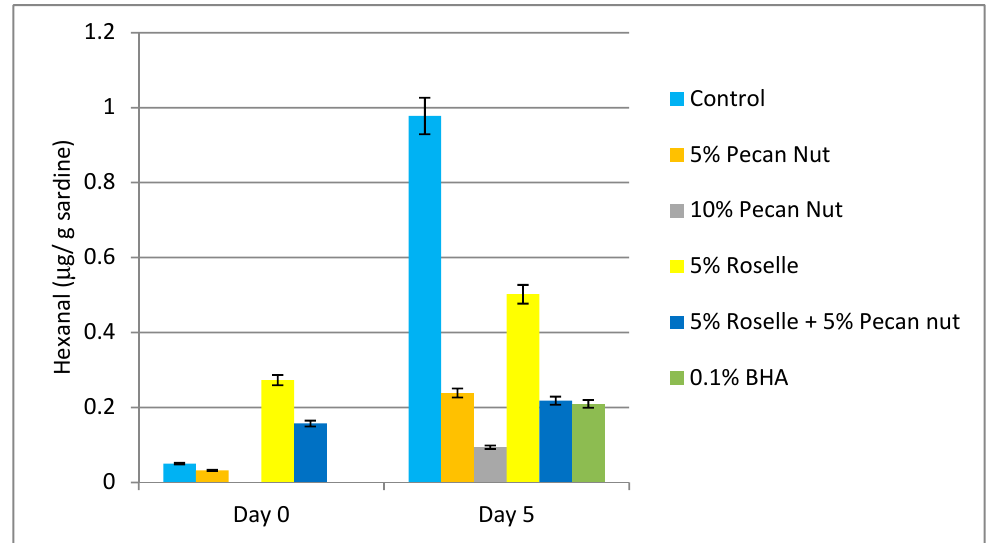
Figure 2. Hexanal content at days 0 and 5 of the experiment in samples of Sardina pilchardus with different treatments 1 . 1 Results are expressed in µ g hexanal/g sardine. At day 0 the amount of hexanal in the samples with treatments of 10% w / w pecan nut and 0.1% w / w BHA are under the limit of detection.